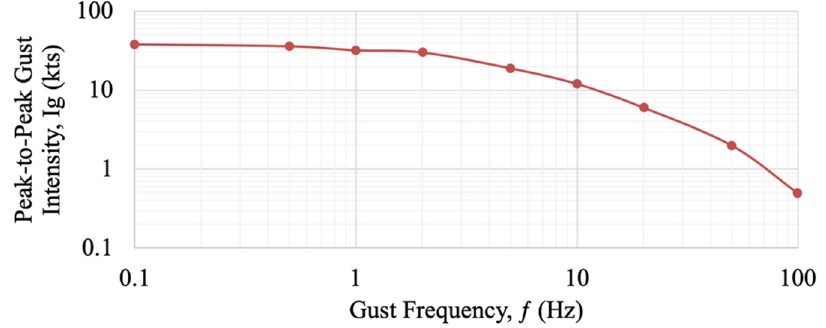
Figure 3. Typical Urban Maximum Gust Profile, 50% Far Field Day.